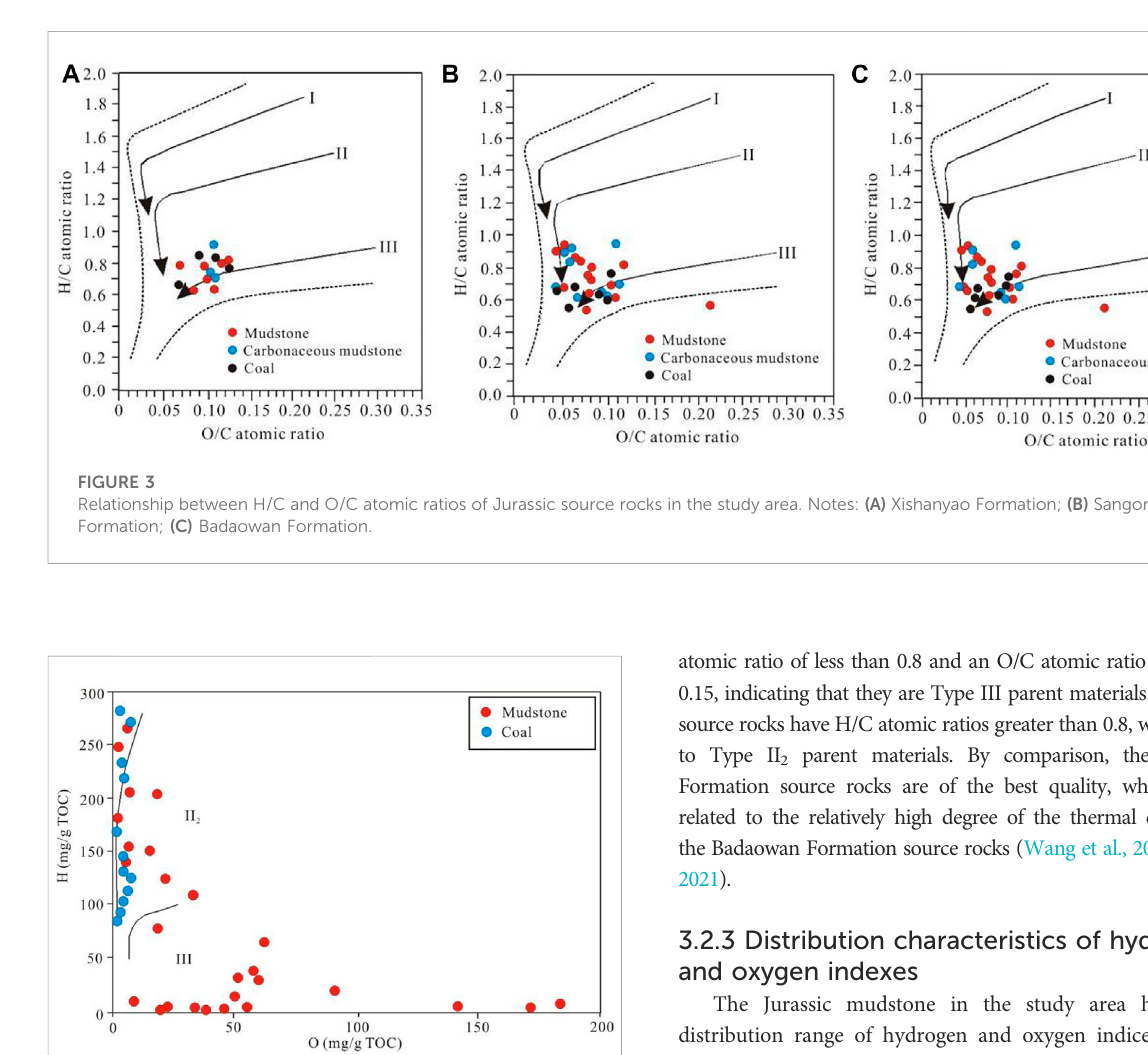
FIGURE 4 Correlation diagram of hydrogen and oxygen indexes of source rocks in Bohu